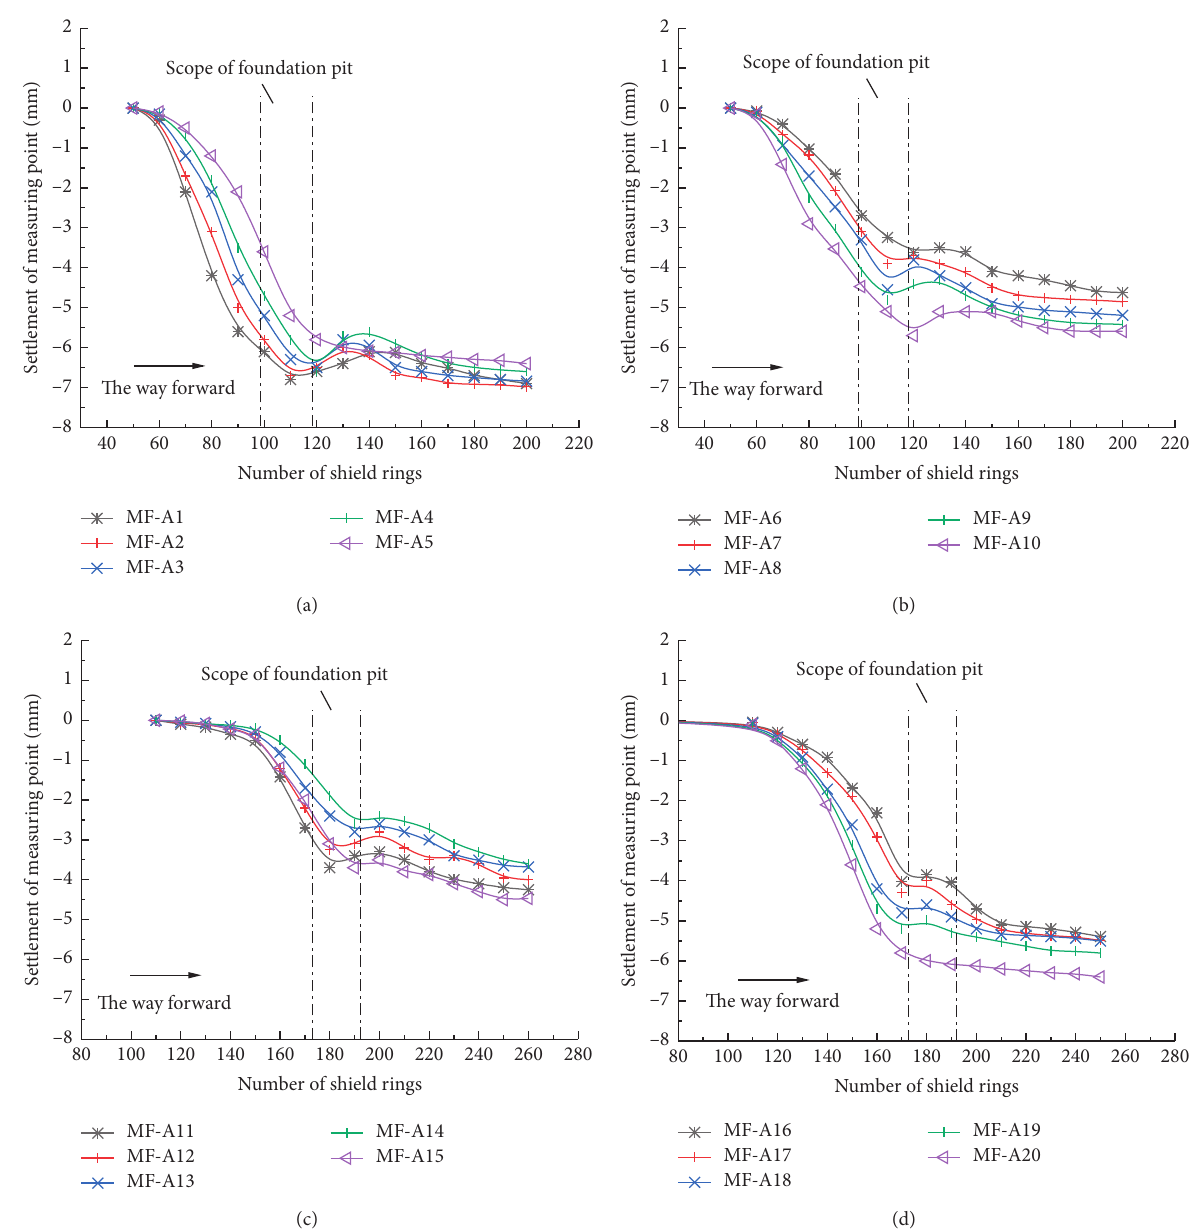
Figure 3: Longitudinal measured deformation of foundation pit. (a) No. 1 foundation pit near tunnel side. (b) No. 1 foundation pit far tunnel side. (c) No. 2 foundation pit near tunnel side. (d) No. 2 foundation pit far tunnel